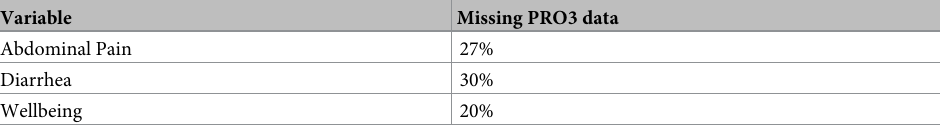
Table 4. Characterization of missing PRO3 elements at baseline. Proportions correspond to the 183 patients who met all eligibility criteria prior to application of the baseline CDAI